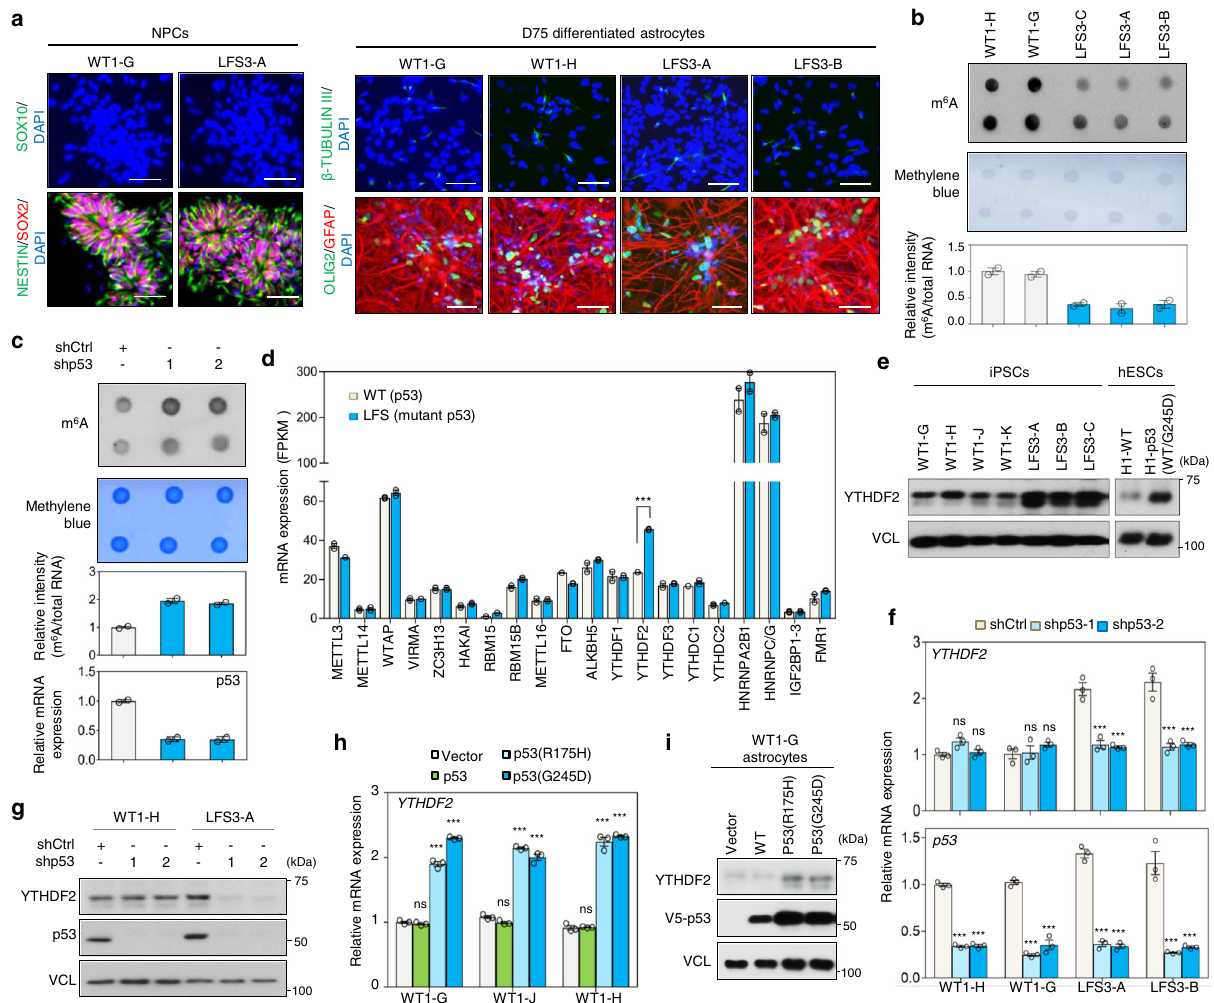
Fig. 1 | Mutant p53 upregulates m 6 A reader YTHDF2 expression in LFS astro- cytes and glioma cells. a Immunostaining indicates iPSC-derived NPCs and astrocytes expressing their corresponding cell markers (SOX2 and NESTIN for NPCs, GFAP for astrocytes, OLIG2 for oligodendrocytes, and β -TUBULIN III for neurons). Scale bar, 50 µ m. b m 6 A methylation dot blotting shows decreased m 6 A methylationinLFSastrocytes.Dotblottingisperformedtoidentifypolyadenylated mRNAs immunoblotted with anti-m 6 A antibodies (upper panel). Methylene blue staining of total mRNA is used as a loading control (lower panel). Dot density is measured by ImageJ. The blotting images represent the results of at least three independent experiments, while the bar charts depict technical replicates within a single experiment. c m 6 A methylation dot blotting indicates increased m 6 A methylationupondepletionofmutantp53inLFSastrocytes.Dotblottingidenti fi es polyadenylated mRNA isolated from shCtrl and shp53 transduced LFS astrocytes and immunoblotted with anti-m 6 A antibodies (upper panel). Methylene